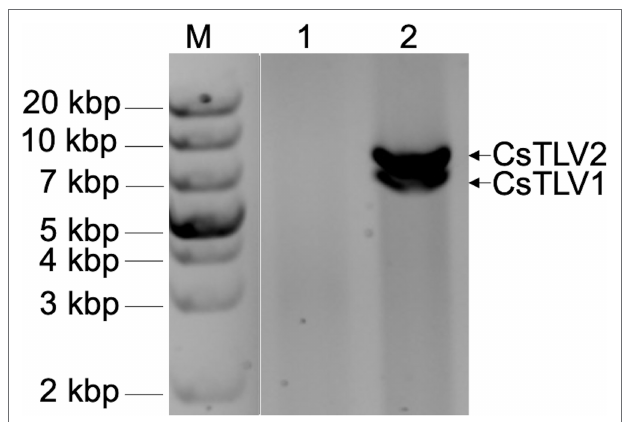
FIGURE 2 | Agarose gel electrophoresis of apparent viral double-stranded RNA (dsRNA) bands of CsTLV1 and CsTLV2. M, marker; Lane 1, control RNA of uninfected blue crab leg muscle; and Lane 2, RNA extracted from infected blue crab leg muscle showing two dsRNA bands of dsRNA-S and dsRNA-L,